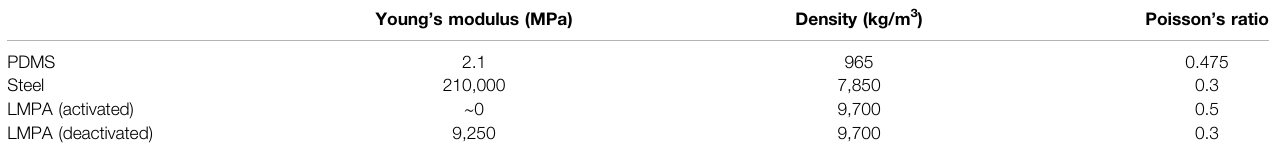
TABLE 1 | The material properties of the composite pad sample that are used in the FEA simulation (Mohammadi Nasab et al.,